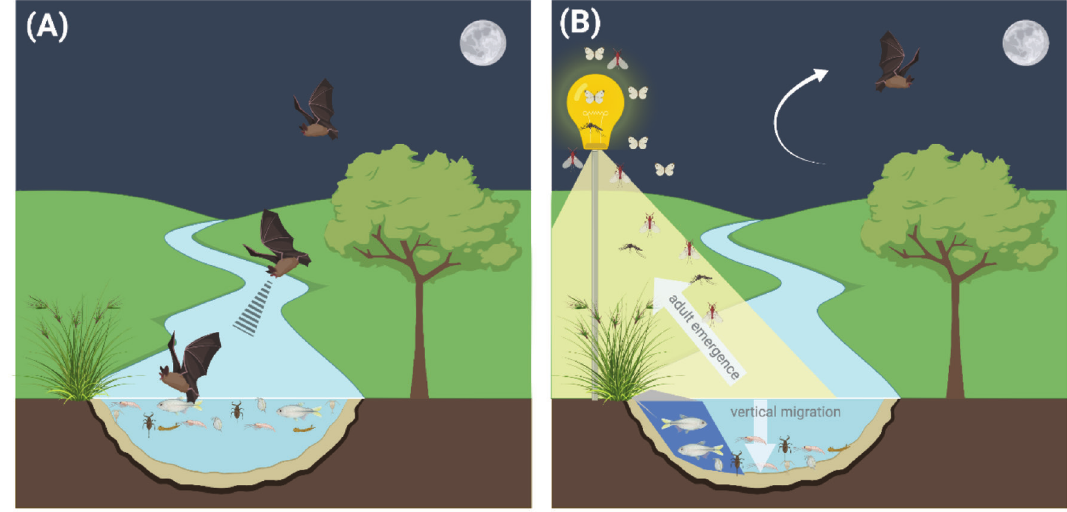
Figure 2 (A) Schematic figure depicting the aquatic ecosystem with fishing bats under natural light (B) and how artificial light at night influences prey species. As artificial light is introduced, aquatic prey species migrate into the shadows, sediment or to greater depths, making them unavailable to bats. Additionally, some aquatic insects emerge as aerial adult forms that are attracted to light. Fishing bats avoid lit areas and cannot switch foraging strategies to take advantage of the new aerial prey that is attracted to lights. Image created with